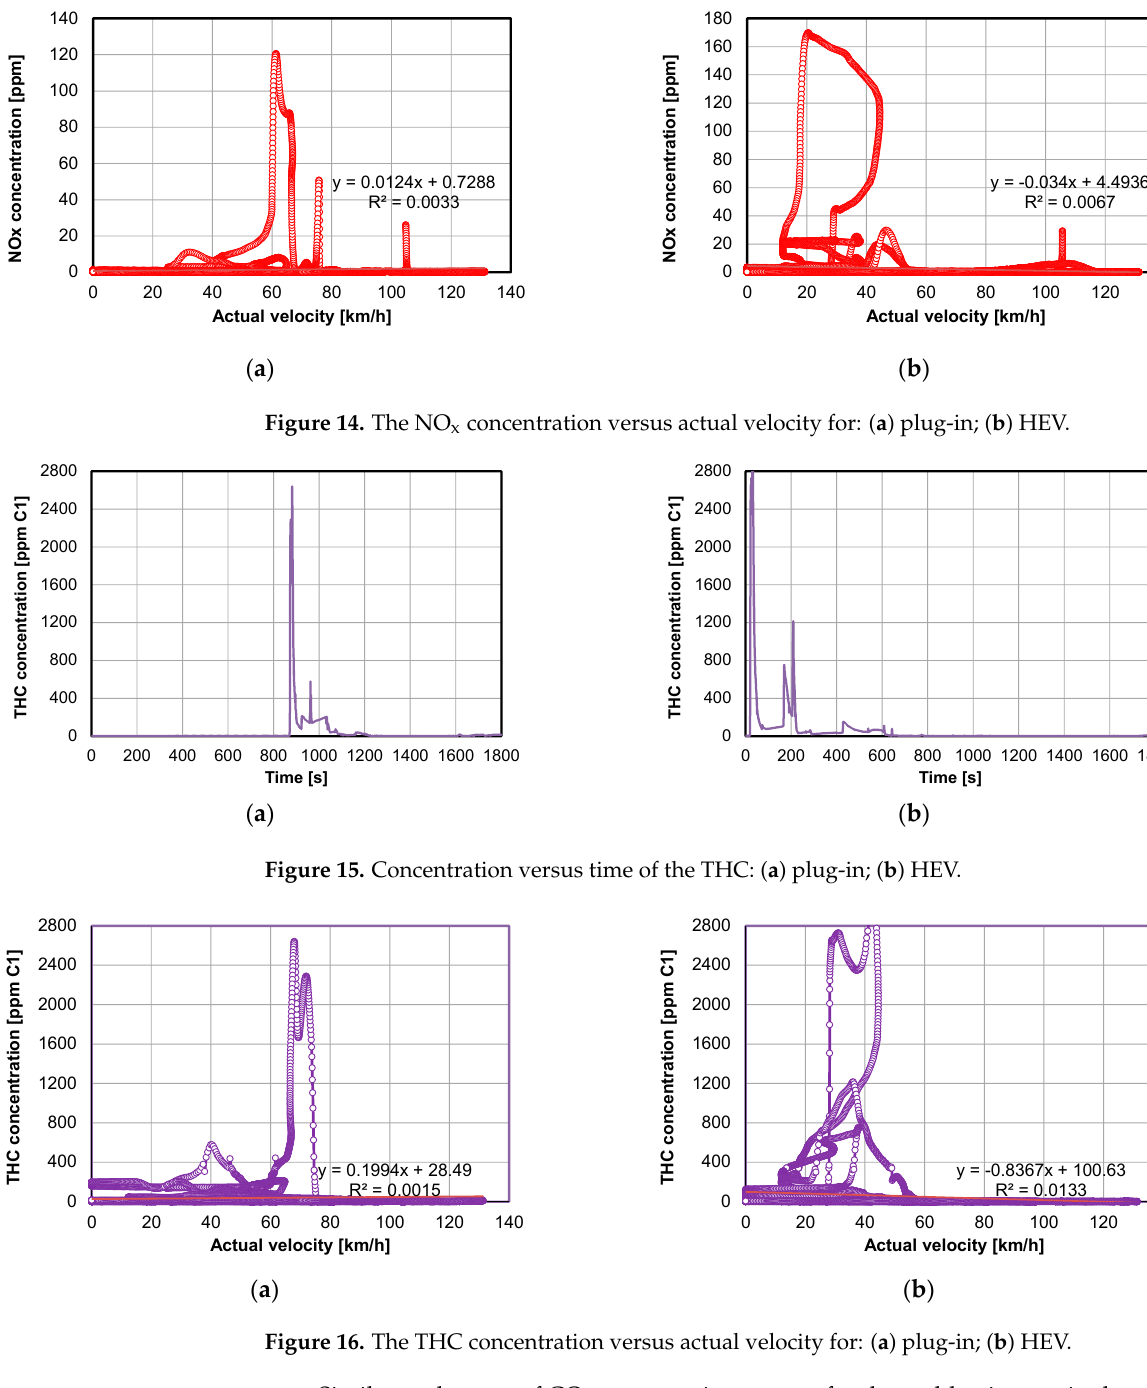
Figure 13. The NO x concentration versus time for: ( a ) plug-in; ( b ) HEV.